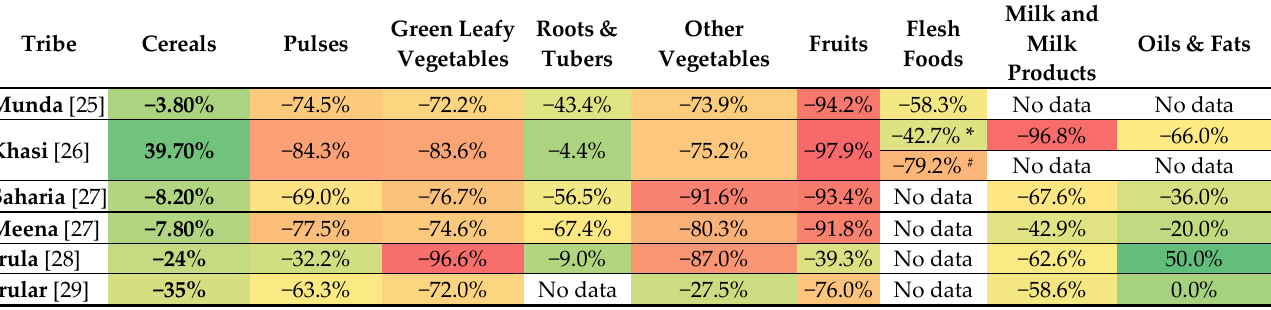
Figure 2. Heat map indicating the percentage deficit/excess in food group consumption among indigenous women of India.